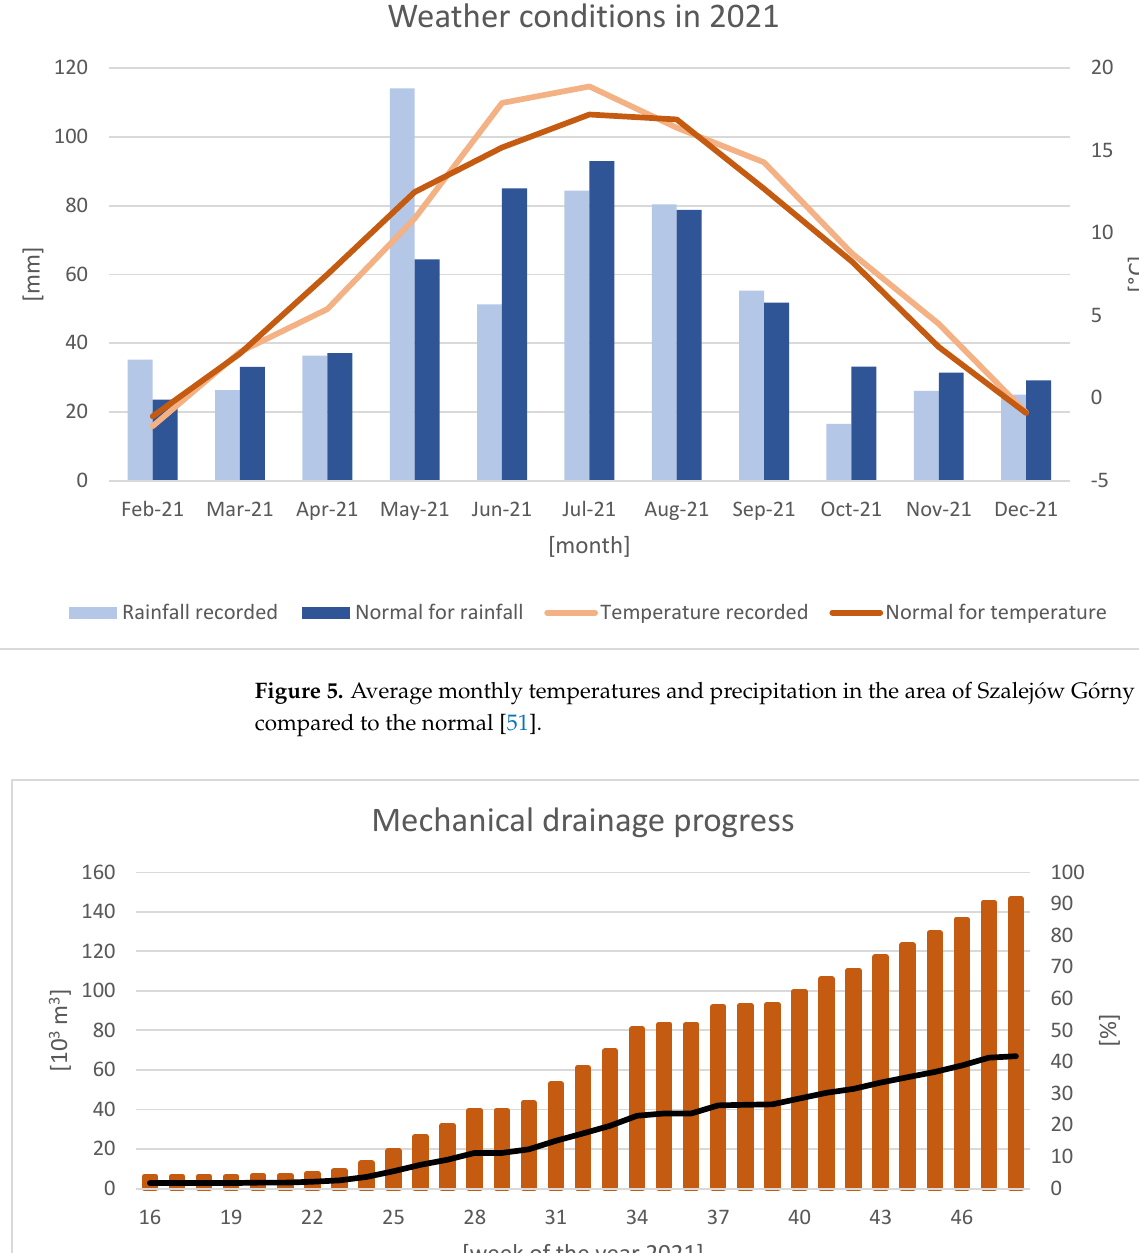
Figure 6. Construction and percentage progress of mechanical drainage of Category I soil (internal analysis based on reports of the project contractor).